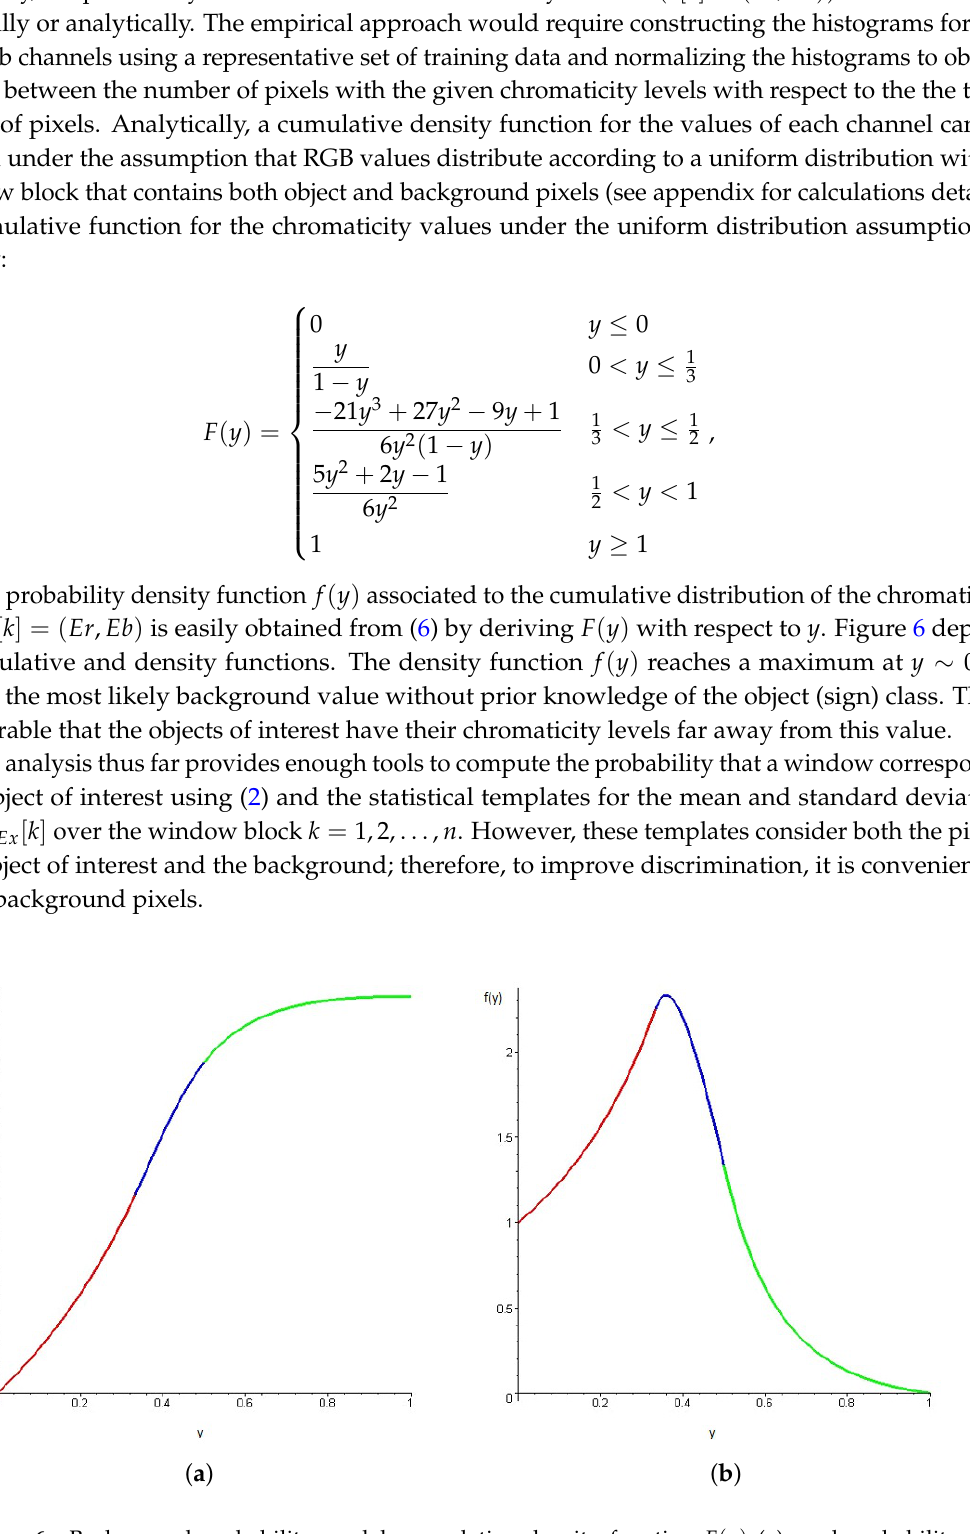
Figure 6. Background probability model, cumulative density function F ( y ) ( a ), and probability density function f ( y ) ( b ), for ErEgEb space, considering that each channel of RGB space follows a uniform